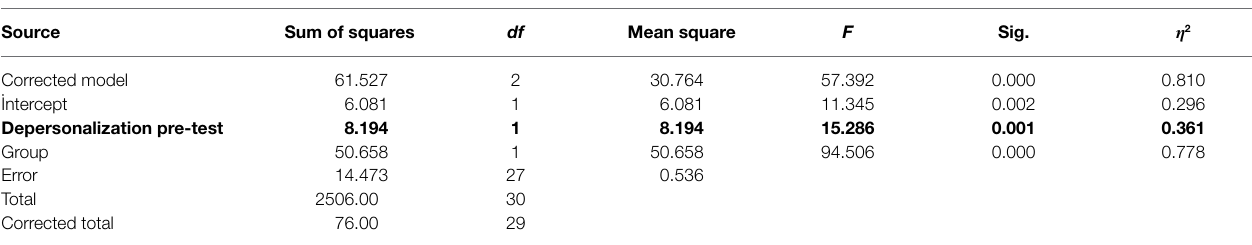
TABLE 7 | Analysis results regarding